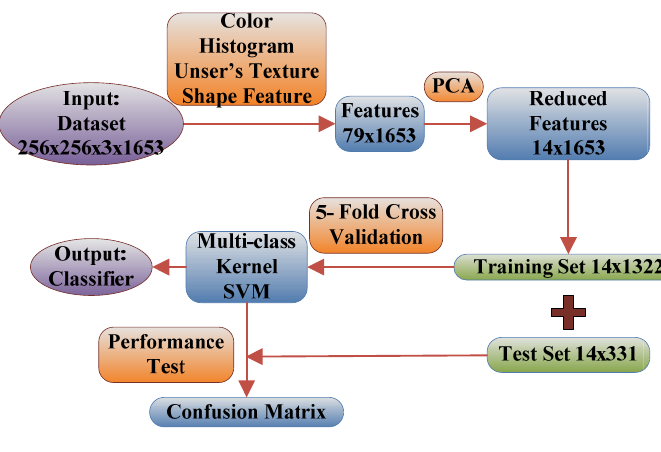
Figure 6. The flowchart of the proposed fruit recognition